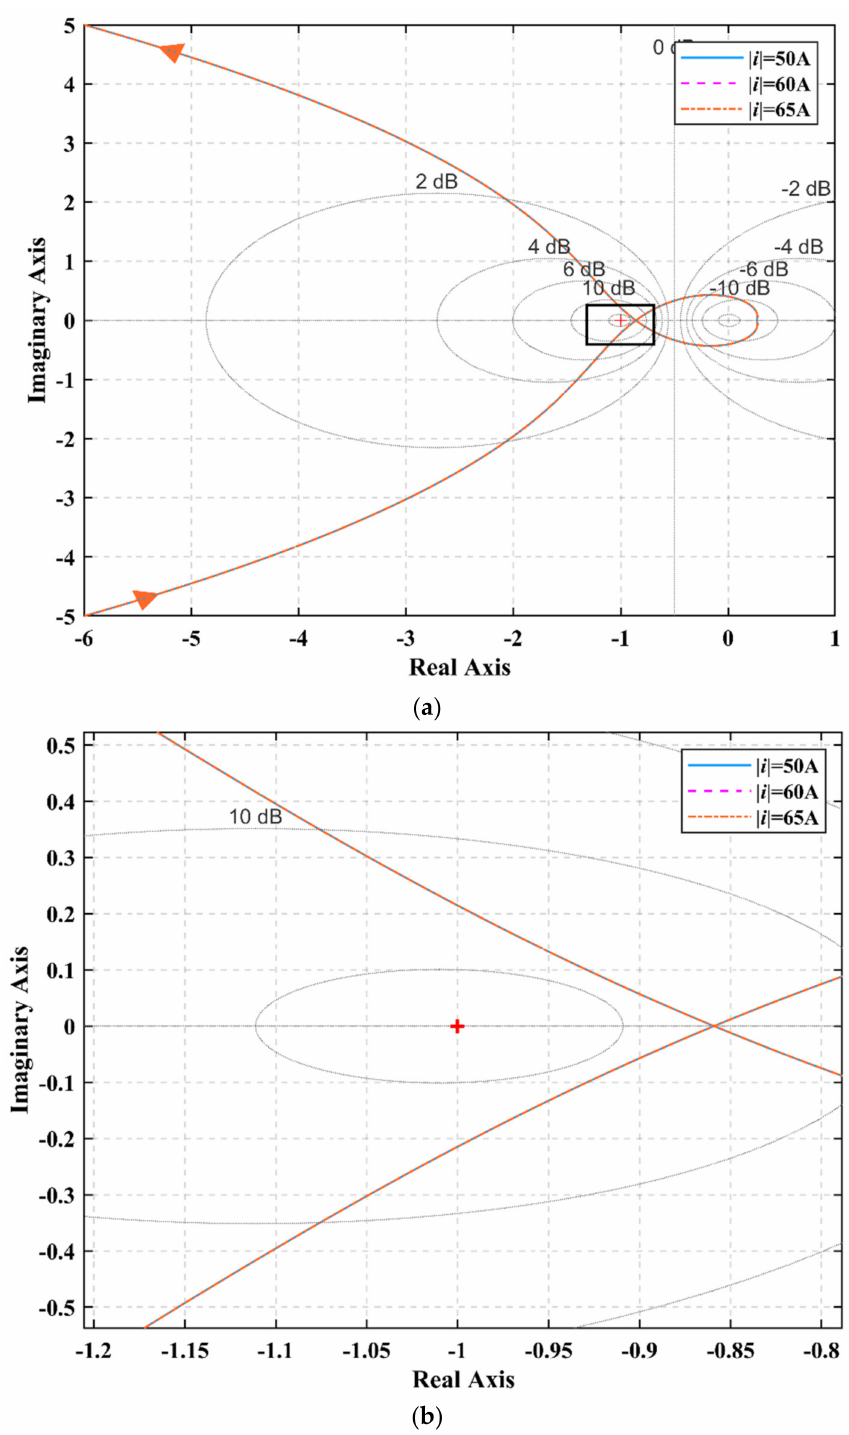
Figure 6. Stability evaluation of the GcC with different current absolute values for the proposed control strategy: ( a ) overall view of the Nyquist curves when the current absolute value varies; ( b ) enlarged views with different current absolute